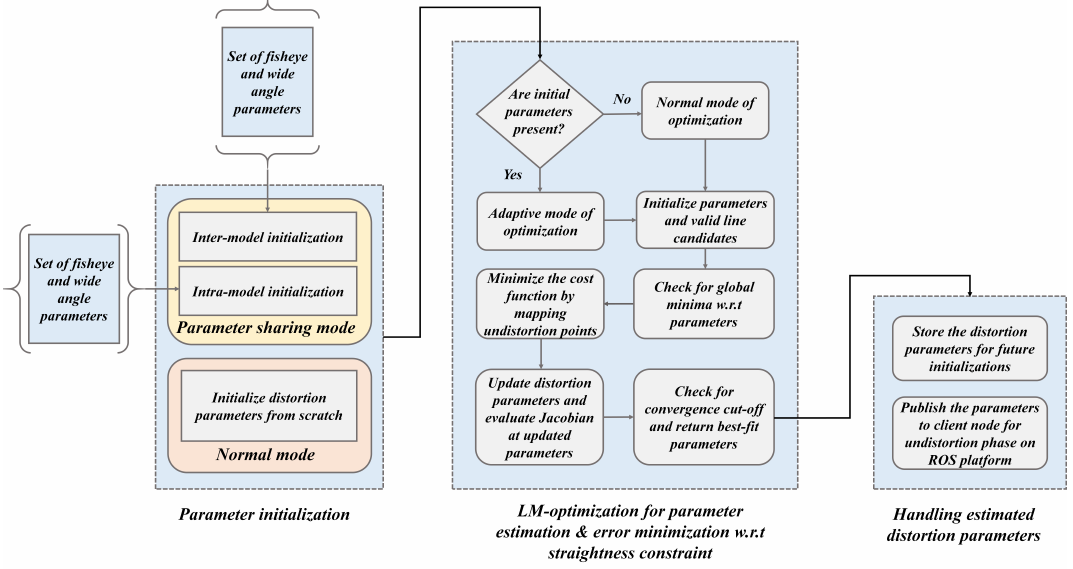
Figure 6. Schematic of distortion parameter estimation using LM-optimization in normal mode and parameter sharing